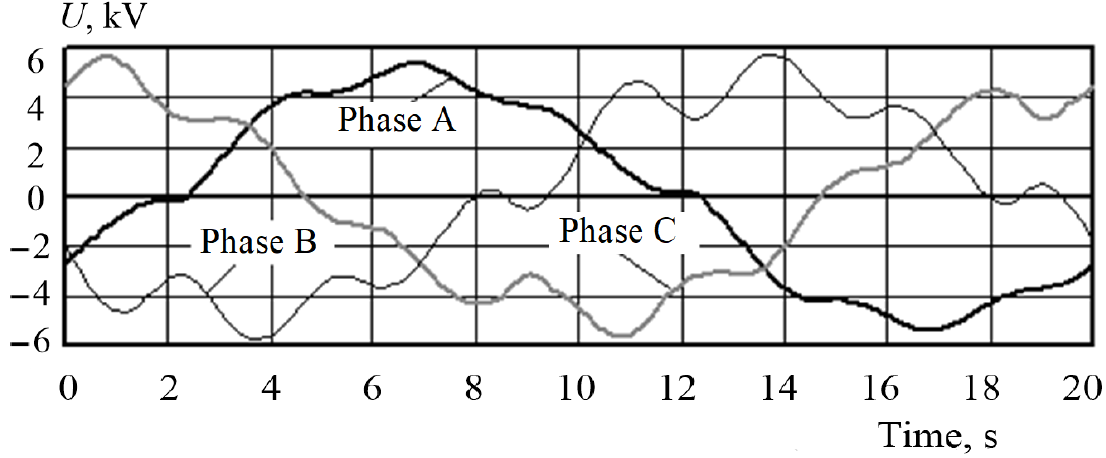
Figure 18. Waveforms of phase voltages at 6 kV busbars of TS2.